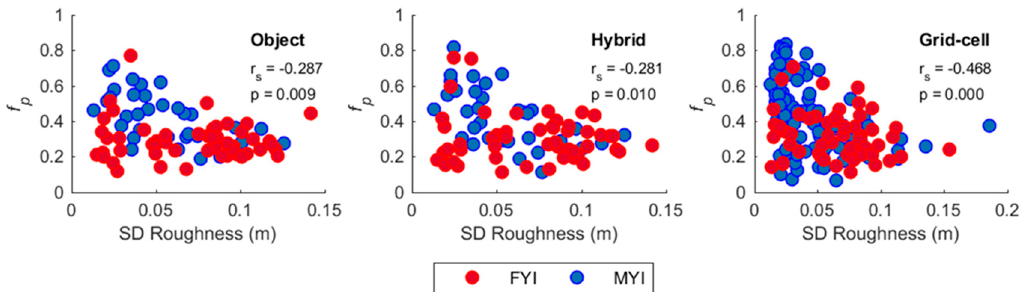
Figure 9. Scatter plots of f p as a function of standard deviation of roughness at the medium scale using object ( left ), hybrid object ( middle ) and 240 m grid-cell ( right ) aggregation approaches. Spearman correlation coefficients (r s ) and corresponding p -values are shown for pooled FYI and MYI data.